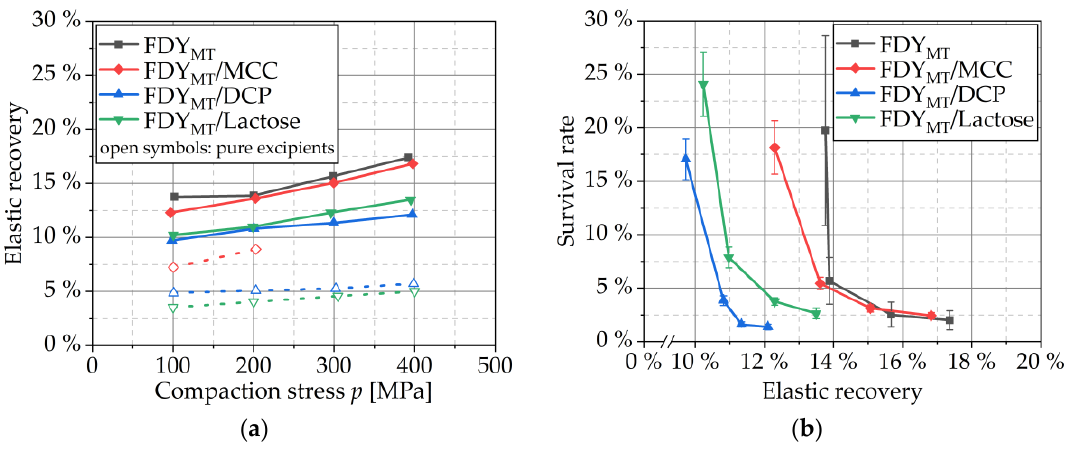
Figure 6. ( a ) Elastic recovery profiles of FDY MT , FDY MT mixed with MCC, DCP and lactose as well as of the pure excipients. Symbols represent means; n = 10. ( b ) Dependency of survival rate on elastic recovery. Symbols represent means and error bars standard deviation; n = 3.